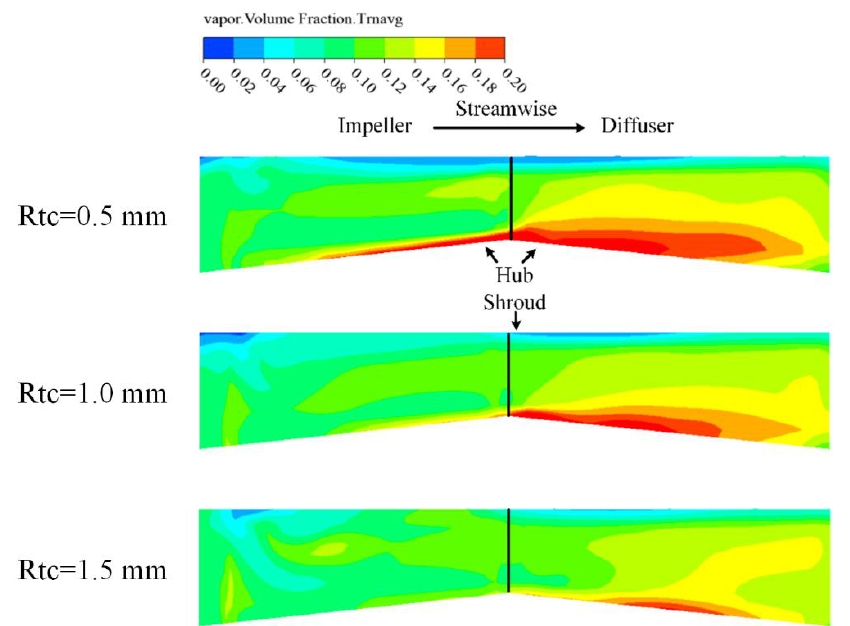
Figure 12. Gas distribution in the impeller and diffuser meridian plane.